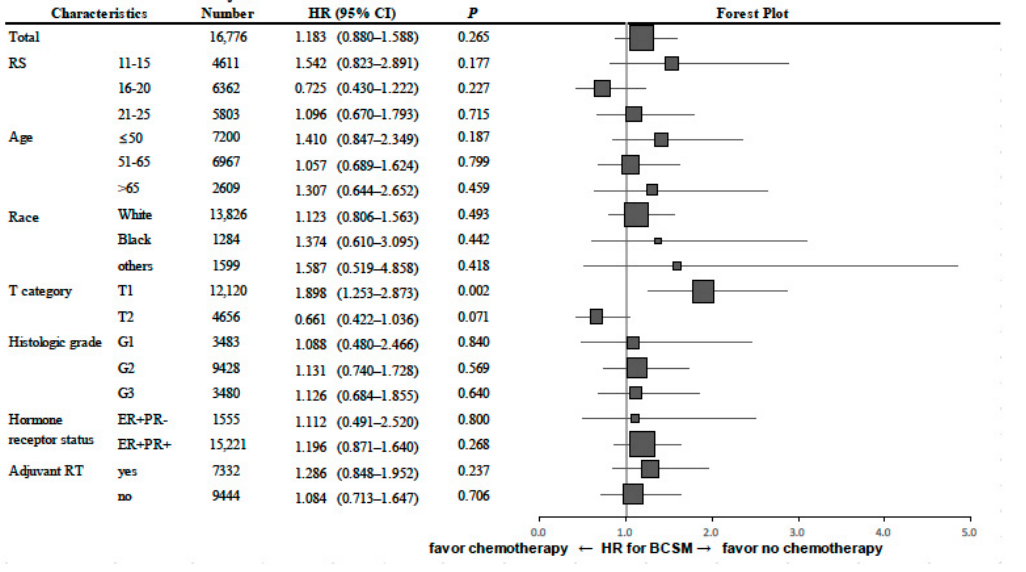
Figure 3. Forest plot demonstrating a comparison of BCSM by treatment arm for chemotherapy vs. no chemotherapy for different subgroups among patients with RS 11–25. Abbreviations: BCSM, breast cancer specific mortality; RS, recurrence score.